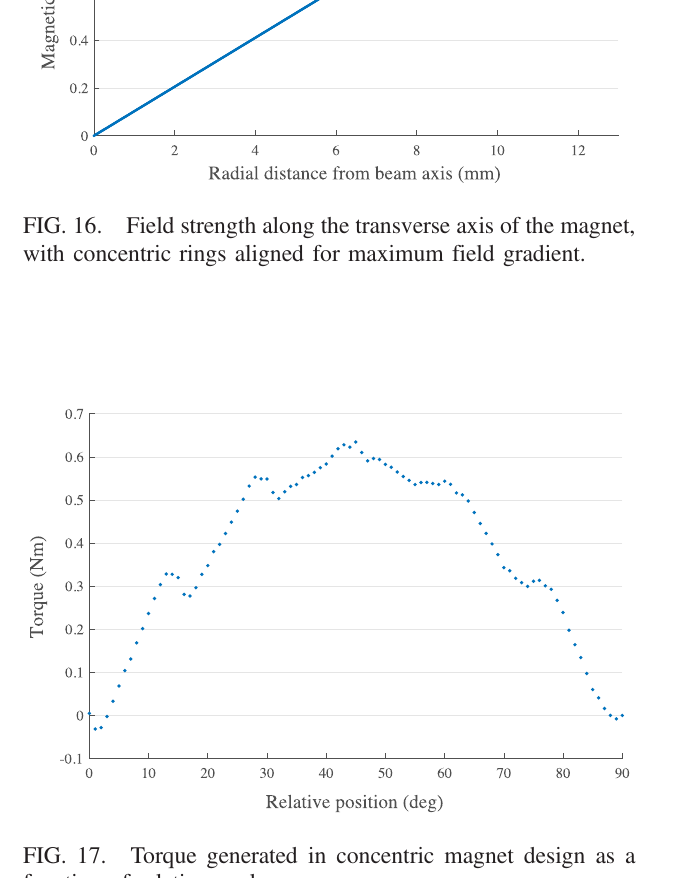
FIG. 19. Mechanical design for the concentric ring